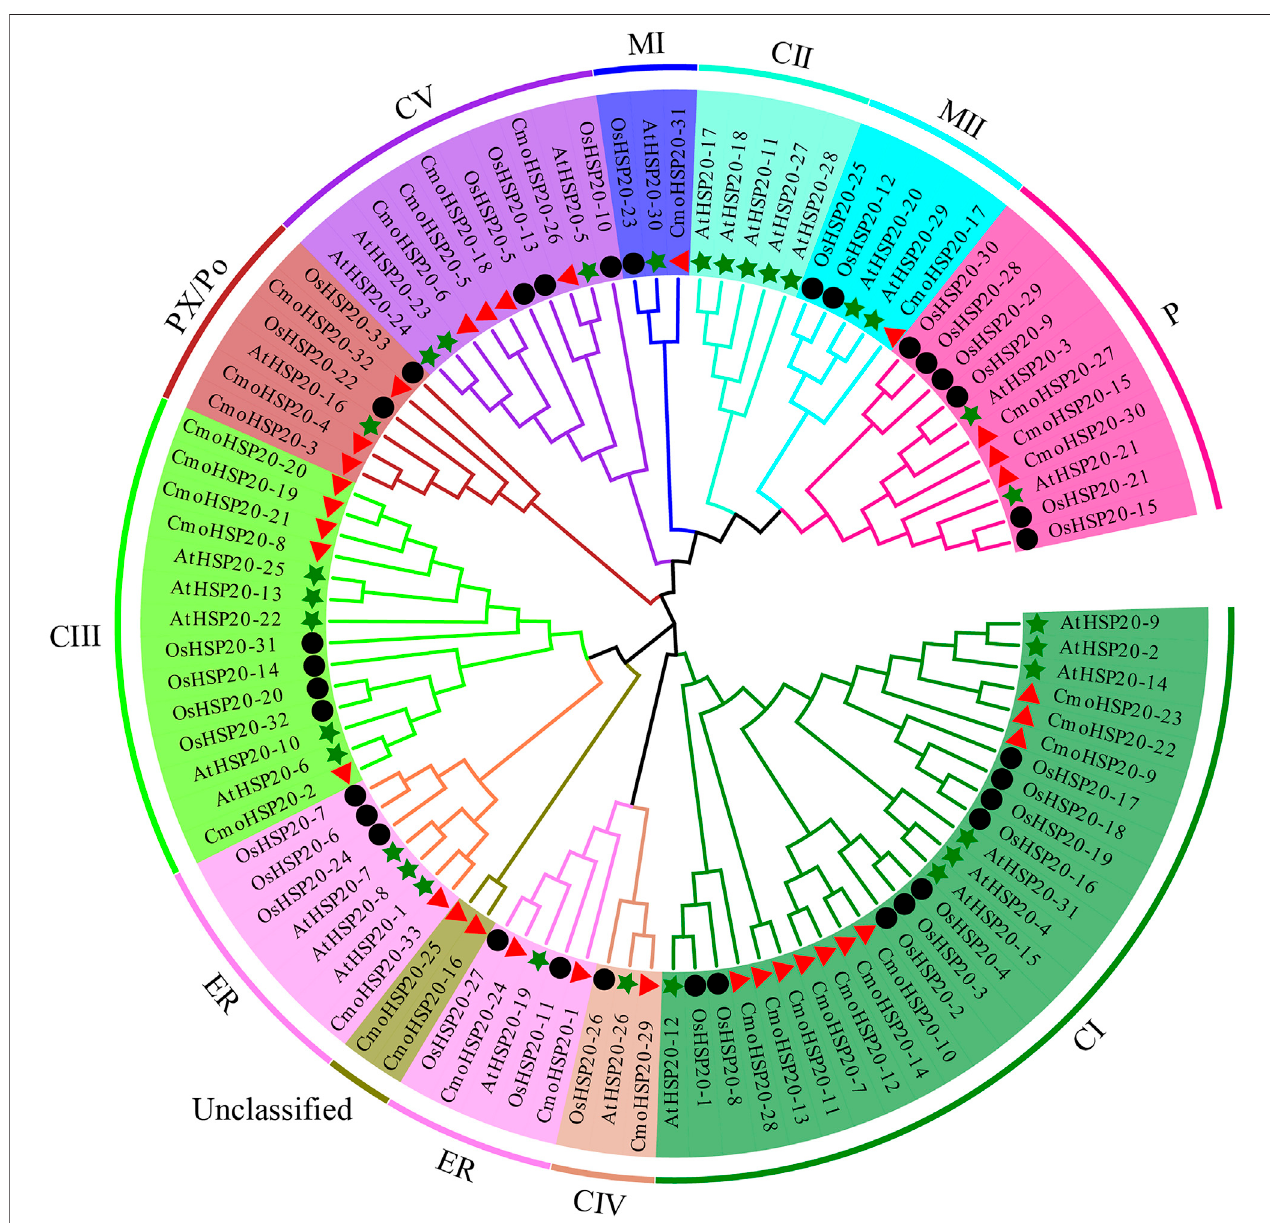
FIGURE 1 | Phylogenetic analyses of HSP20s proteins from Cucurbita moschata , Arabidopsis and Oryza sativa . A phylogenetic tree of HSP2 proteins was constructedusingMEGA-Xsoftware. The10subgroups areindicatedwithdifferentcolors.Theredtrianglesrepresent Cucurbitamoschata HSP20s(CmoHSP20s),the green stars represent Arabidopsis thaliana HSP20s (AtHSP20s), and the black circles represent Oryza sativa HSP20s (OsHSP20s).